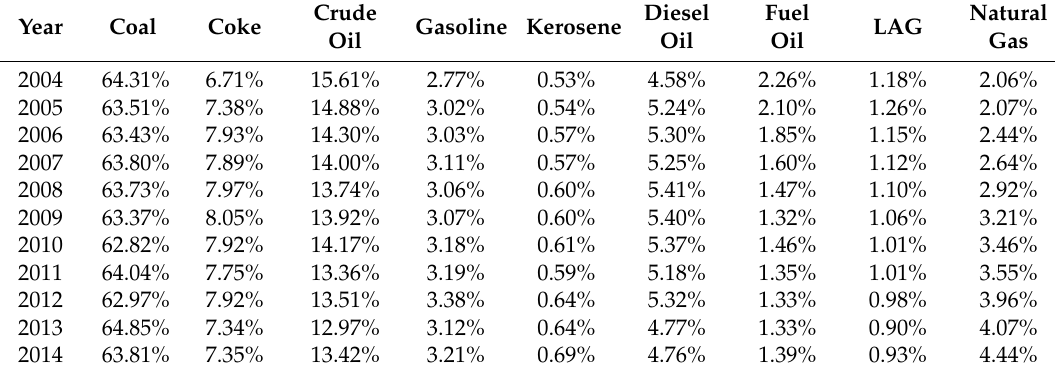
Table 5. The structure of energy consumption of China in 2004–2014.